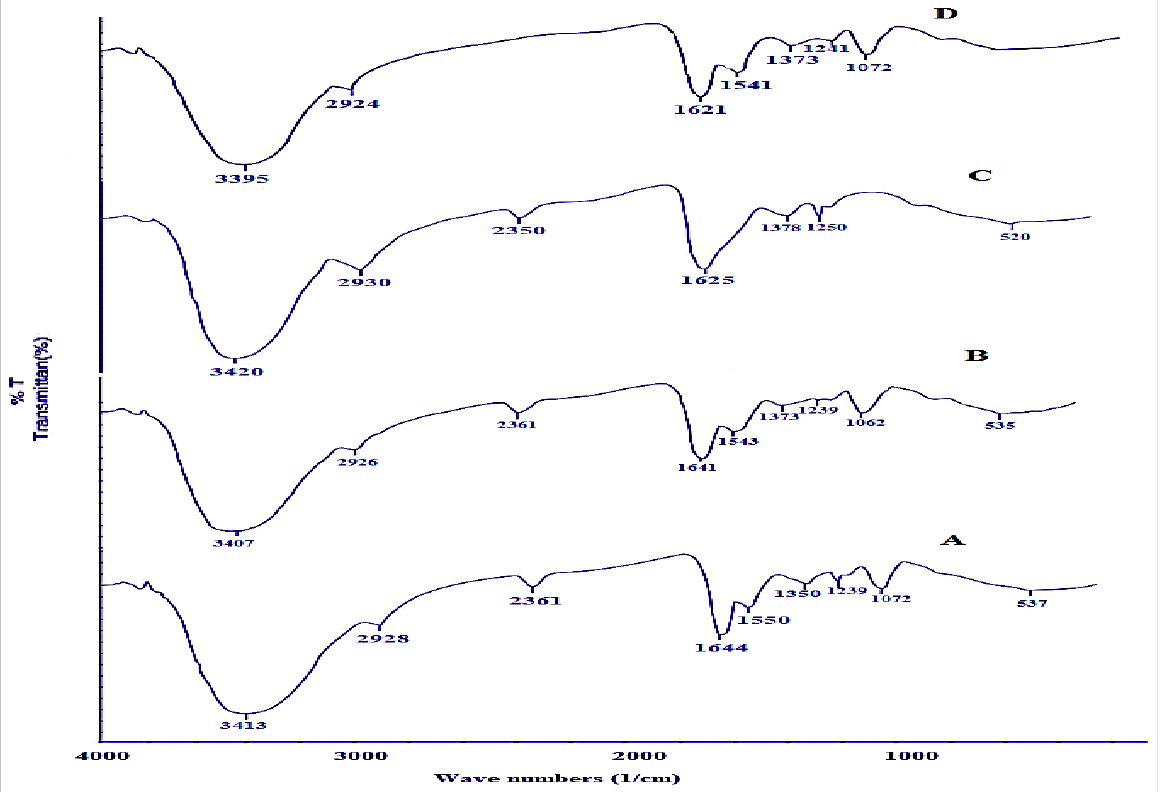
Figure 7. FTIR spectrum of raw S. cerevisiae ( A ) and lead- ( B ), cadmium- ( C ), and nickel ( D )-loaded S. cerevisiae.